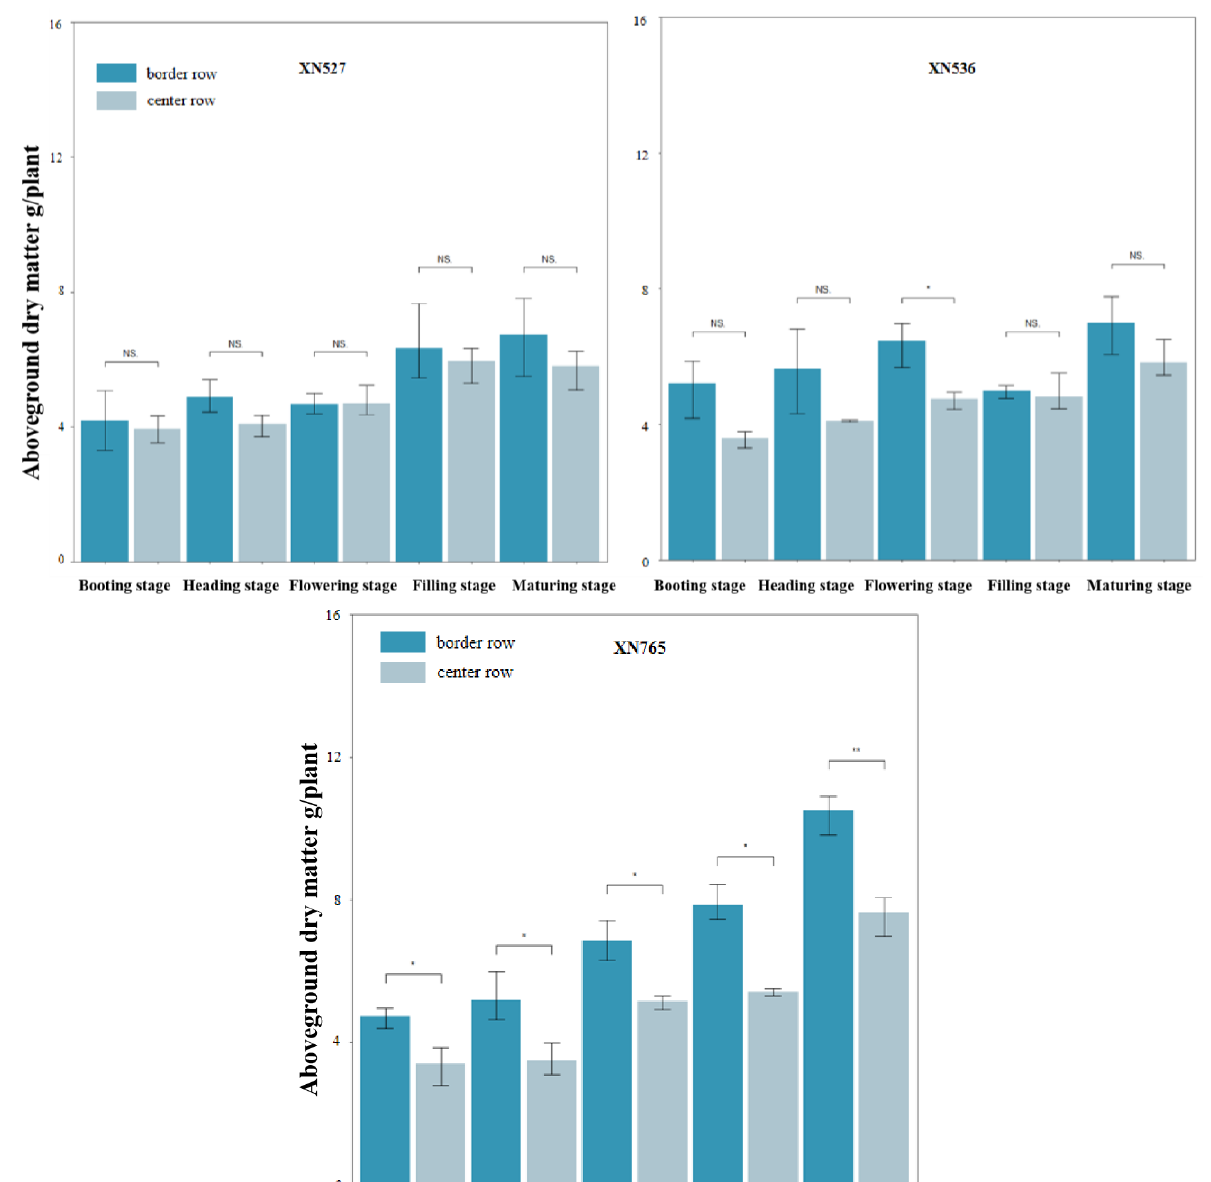
Figure 3. Border effect of aboveground dry matter of wheat in different stages. (*: p ≤ 0.05, **: p ≤ 0.01, and NS: non-significant (ANOVA)).